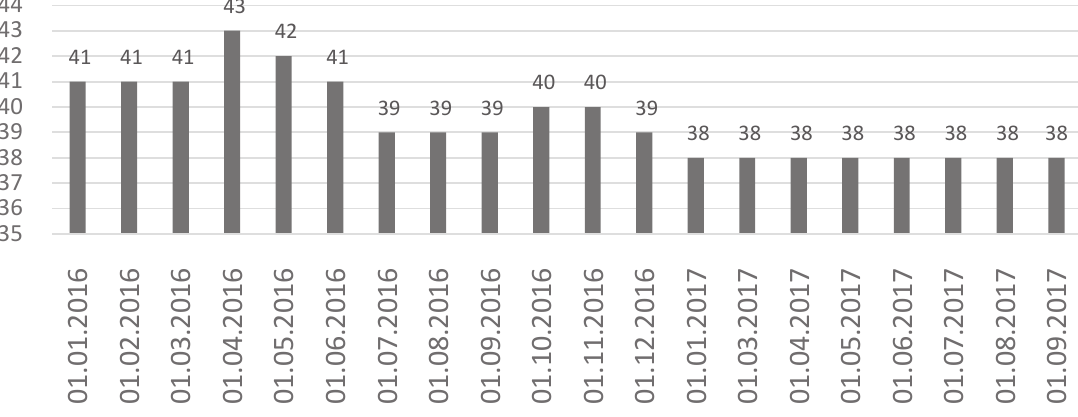
Figure 2. Number of operating banks with foreign capital in Ukraine in 2016 – September